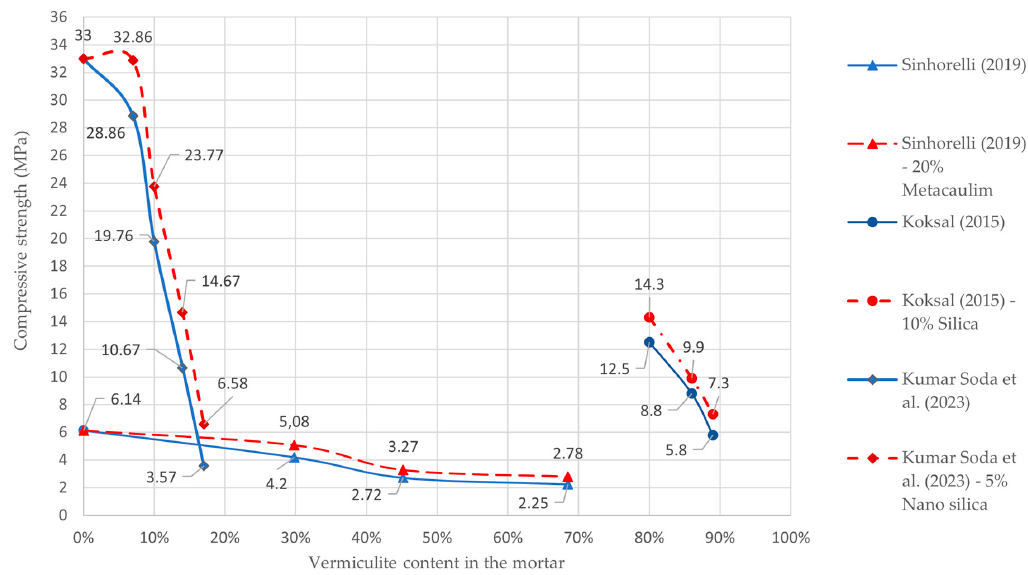
Figure 11. Correlation between vermiculite content in the mixture and compressive strength in samples with and without mineral addition [45,48,64].